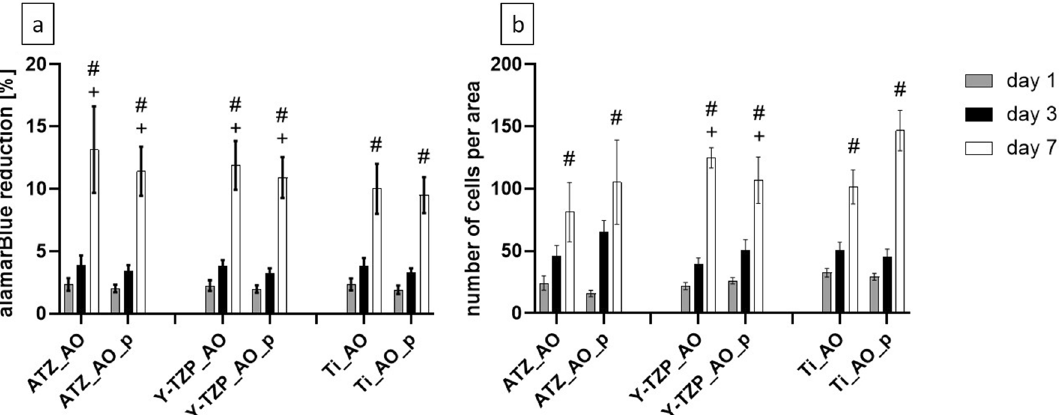
Figure 12. Metabolic activity ( a ) and total cell number per area determined by counting the cells on micrographs ( b ). The percentage of alamarBlue reduction in the supernatant refers to a 100% reduced control. Data are presented as mean values ± SEM (data collected on 6 biomaterial discs). No statistically significant differences were found between the different biomaterial groups. “+” marks statistically significant differences between day 3 and day 7 and “#” between day 1 and day 7.